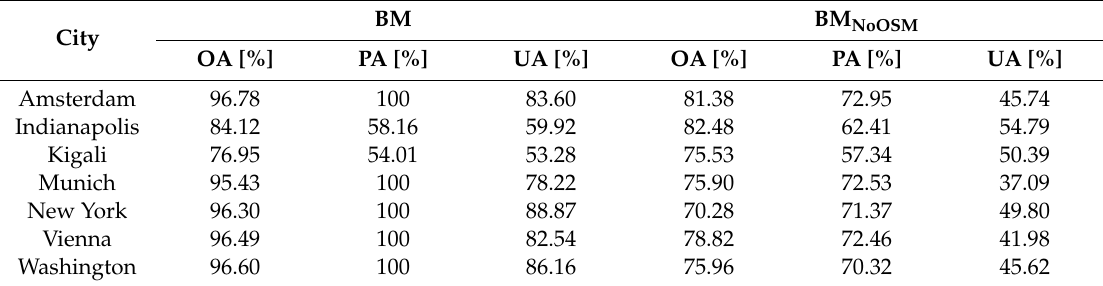
Table 2. Overall accuracy (OA), producer’s accuracy (PA) and user’s accuracy (UA) of the building masks (BMs) generated for the test